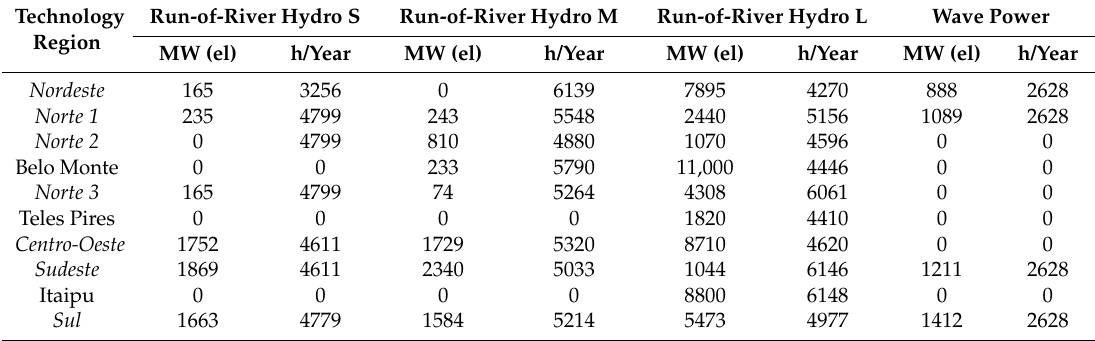
Table A4. Considered run-of-river hydro and wave power capacities and annual full load hours based on [46,47].